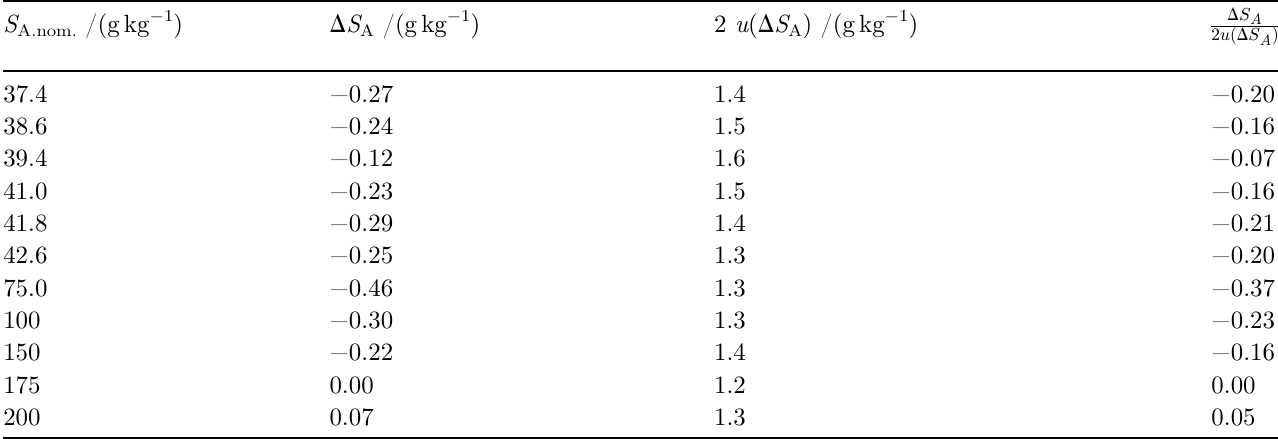
( n ); S ( r )), and the corresponding 2 u ( D S A A